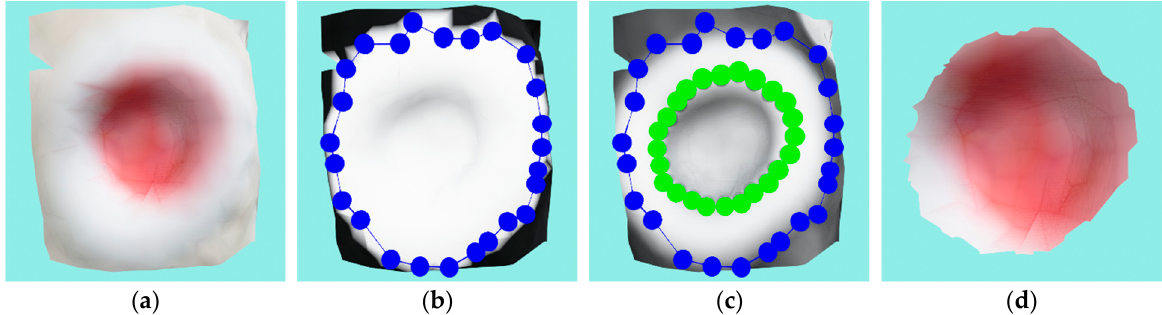
Figure 19. Case study for a neuropathic ulcer: ( a ) input wound mesh; ( b ) masked wound mesh with initial contour; ( c ) wound mesh with curvature texture and initial and final contours shown in blue and green colors, respectively; ( d ) final cut wound mesh model.